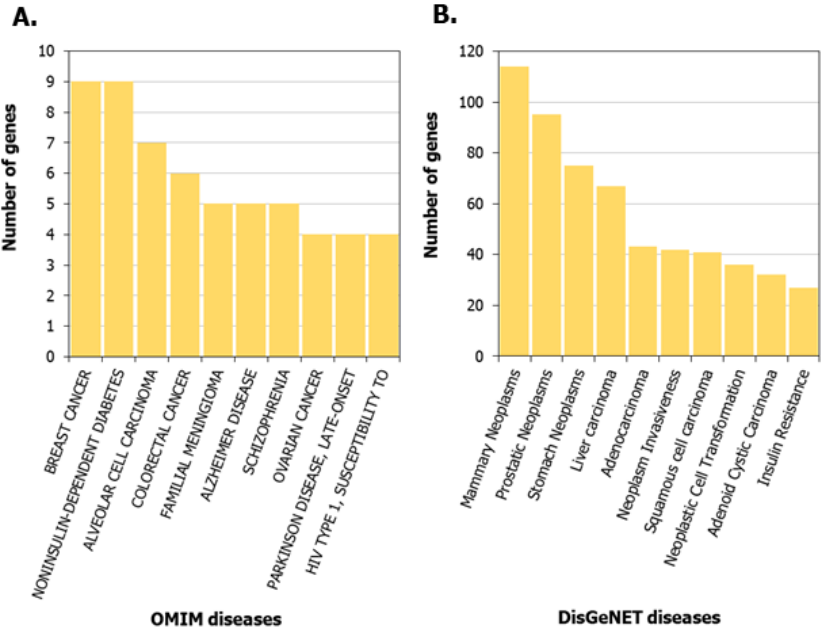
Figure 3. Pathways associated with the hypoplastic left heart syndrome (HLHS) interactome: The number of proteins from the HLHS interactome that are involved in the top 30 pathways most sig- nificantly associated with the interactome are shown.